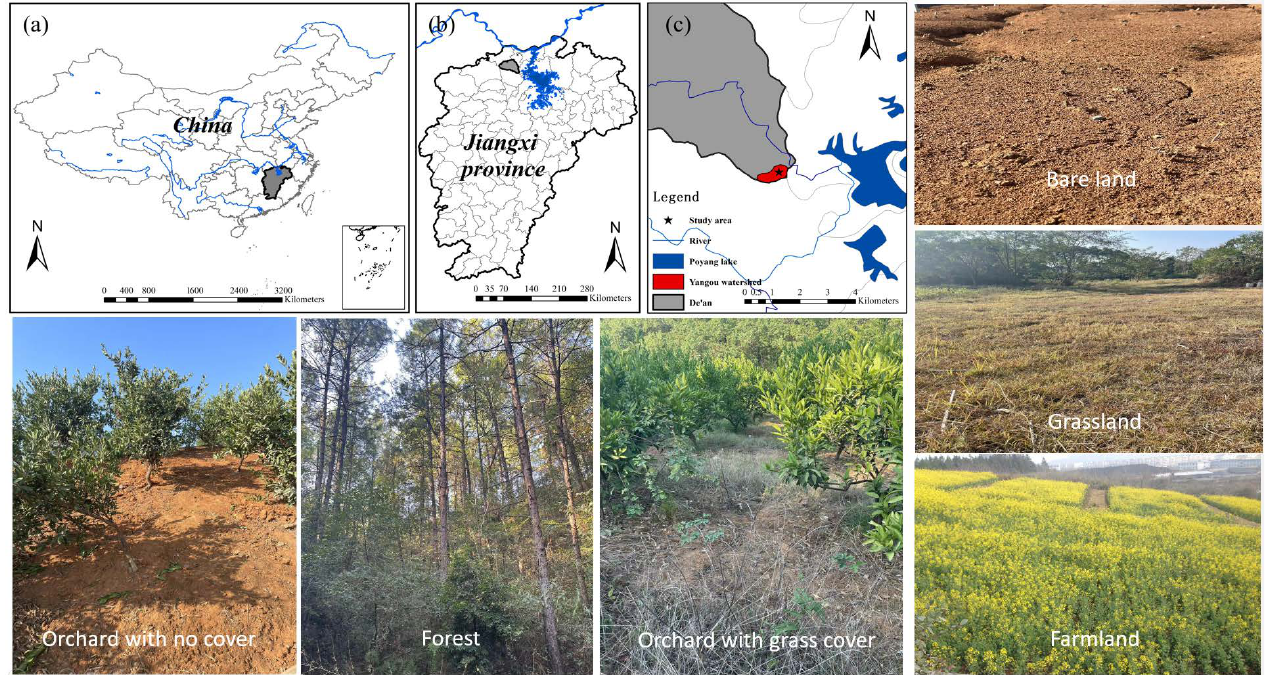
Figure 1. Location of the study area. , China ( a ), Jiangxi Province ( b ), Jiangxi Ecological Park of Soil and Water Conservation ( c